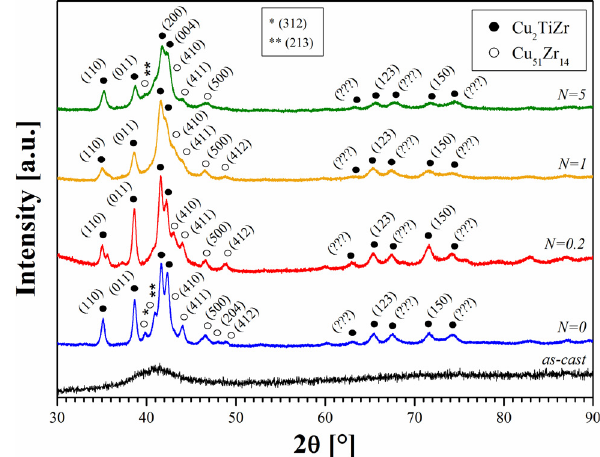
Figure 1: XRD patterns of as-cast, compressed (N=0) and different (N=0.2, 1, 5) HPT deformed Cu 60 Zr 20 Ti 20 samples. Diffraction peaks of the crystalline Cu 2 ZrTi and Cu 51 Zr 14 phases are